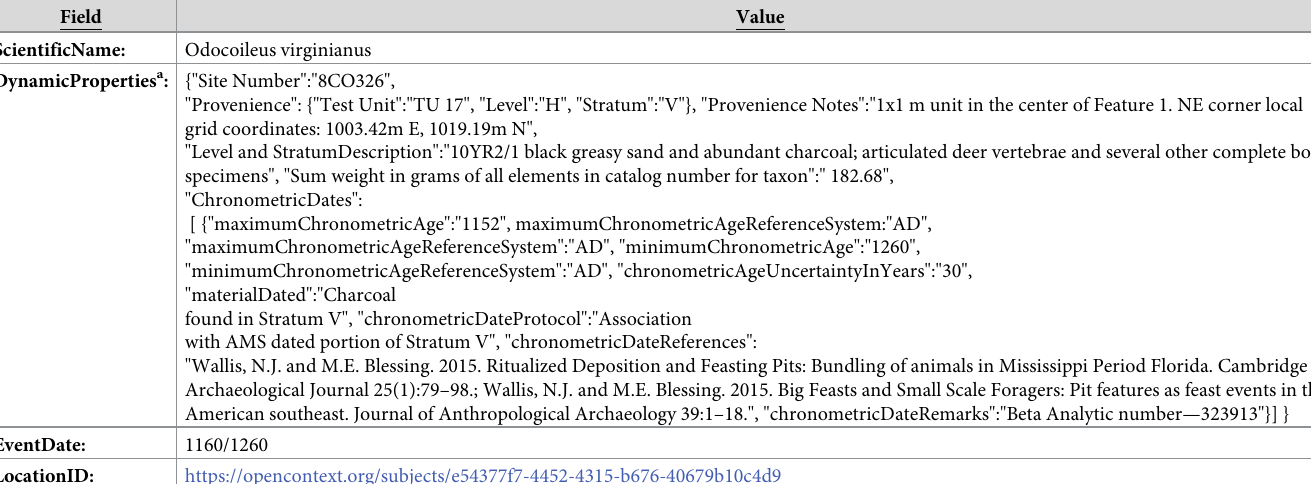
LOD application and linking to Open Context as an exemplar archaeological open data publisher. The ZooArchNet implementation relies on the foundations provided by the bio- diversity and archaeological data communities, and in both of these, Linked Open Data is still Table 3. Example fields extracted from a ZooArchNet published specimen. Field